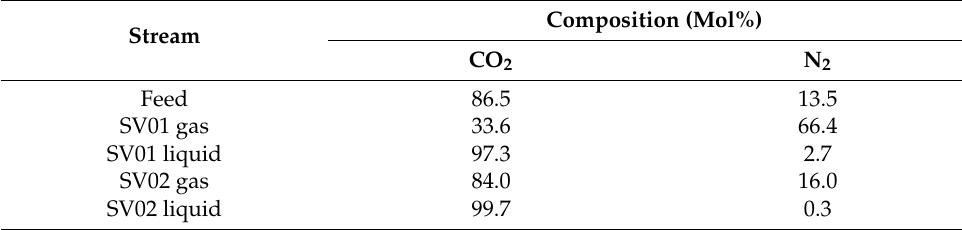
Table 4. GC measurements at the initiation of Experiment 3.